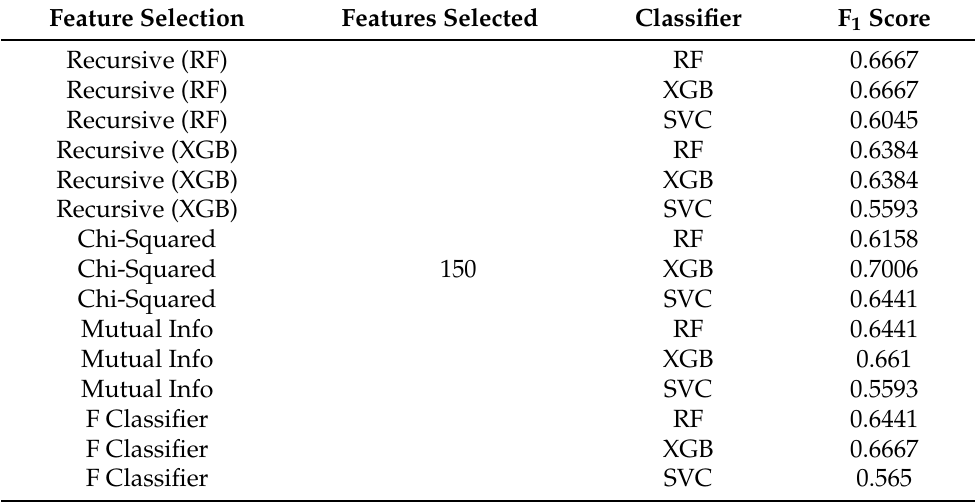
Figure 6. F 1 Scores for Google pre-trained word embedding, without any feature selection methods. Table 4. F 1 scores obtained by using Google pre-trained Word2Vec embedding and selecting 150, 100, and 50